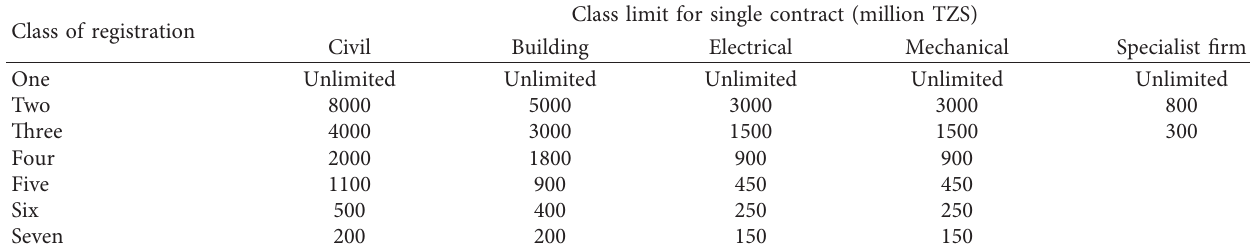
Table 2: Classification of contractor enterprises in